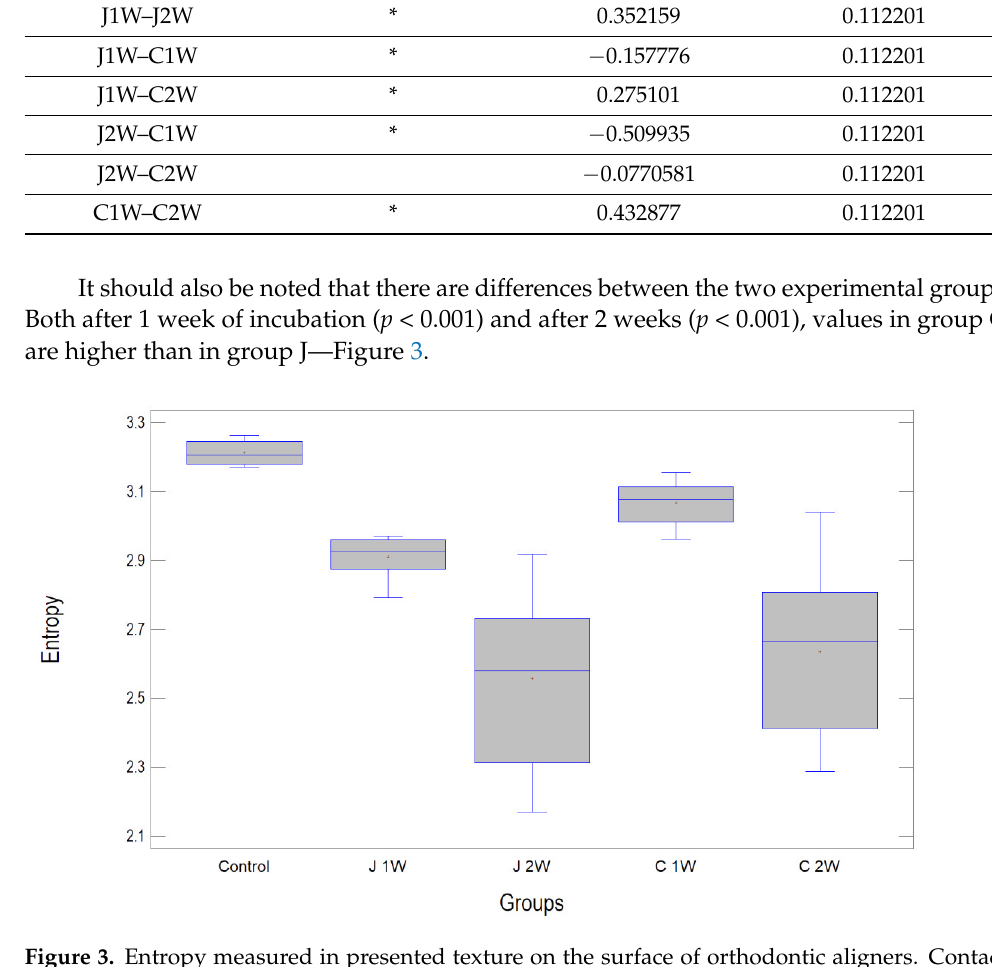
Figure 3. Entropy measured in presented texture on the surface of orthodontic aligners. Contact with incubation fluid decreases entropy in a time-dependent manner. Abbreviations: J1W—orange juice incubation 1 week, J2W—orange juice incubation 2 weeks, C1W—Coca-Cola incubation 1 week, C2W—Coca-Cola incubation 2